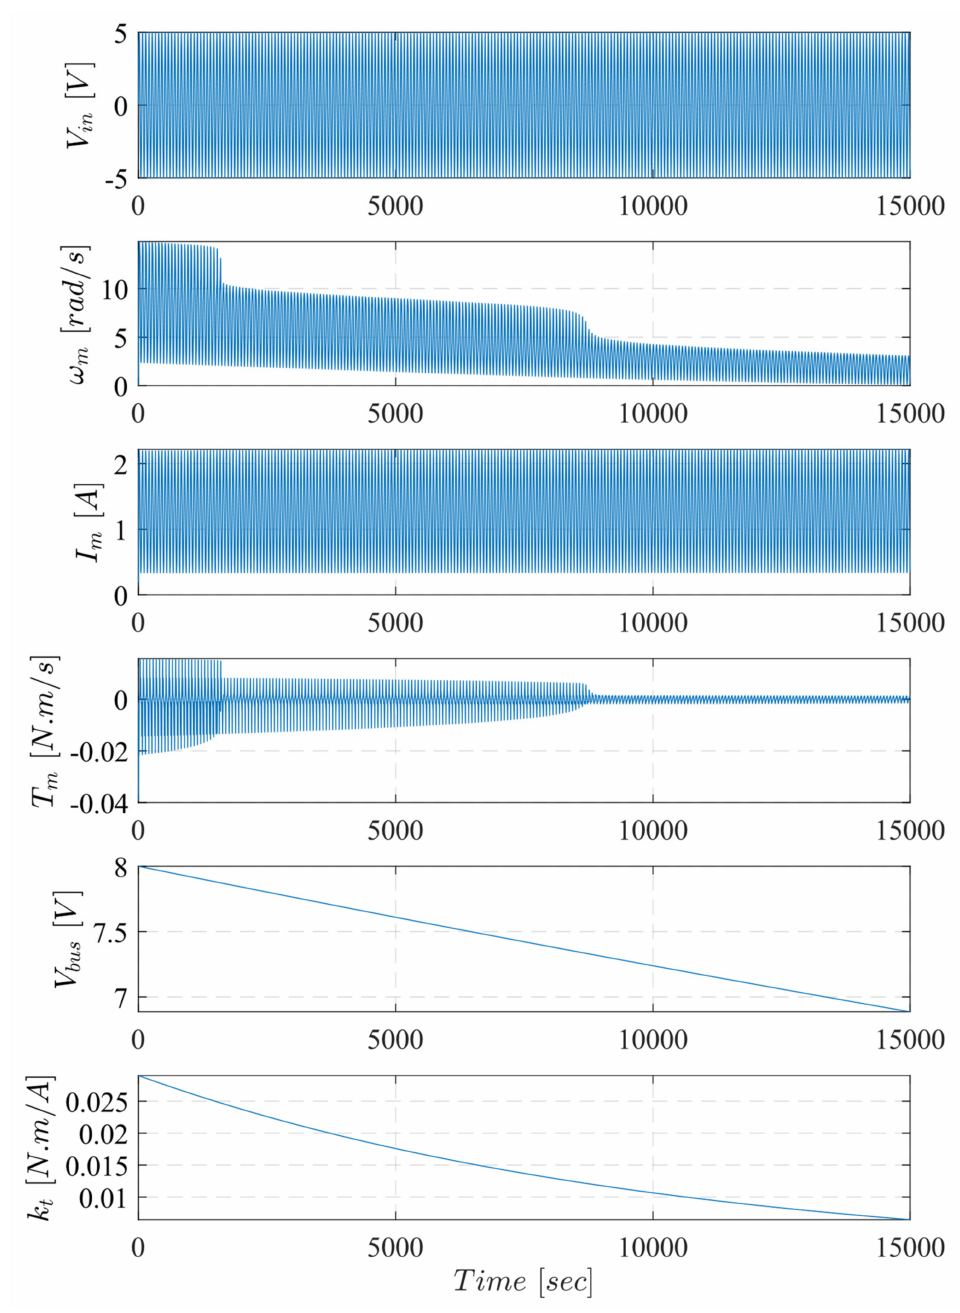
Figure 5. RW simulation data sample from ITHACO